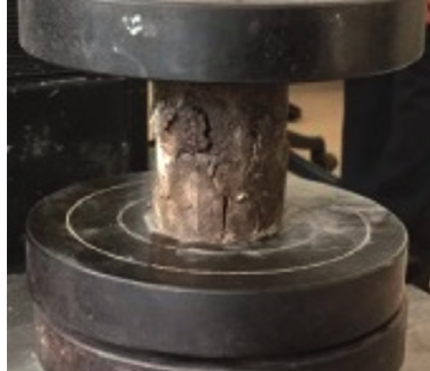
Figure 5: Failure schematic diagram of